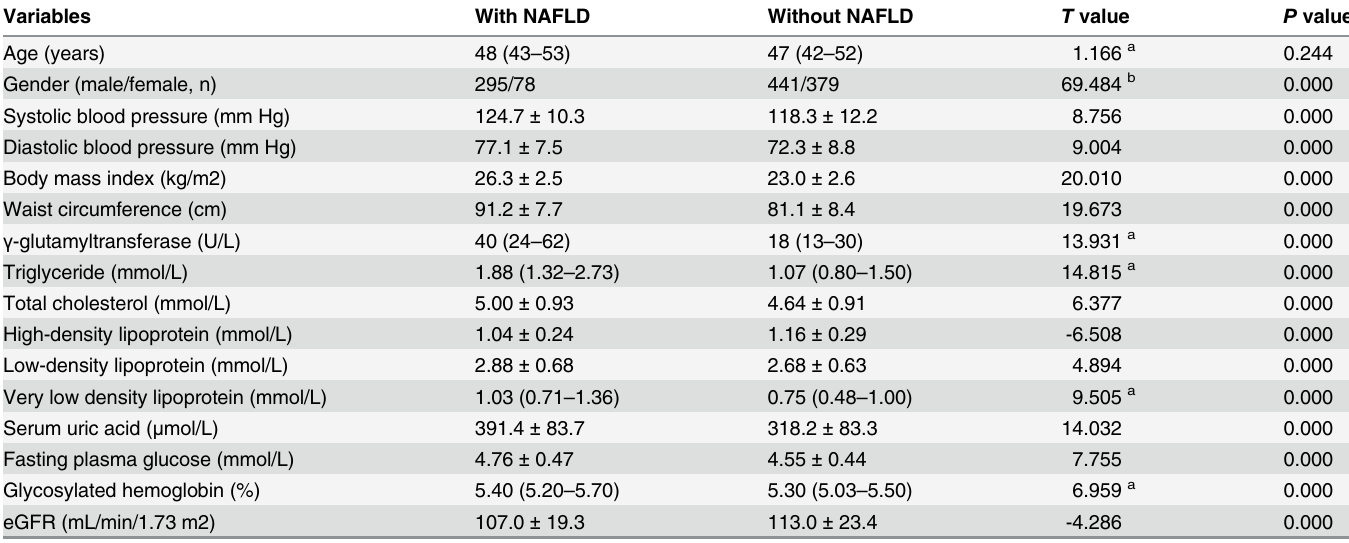
Table 1. Subject characteristics according to NAFLD